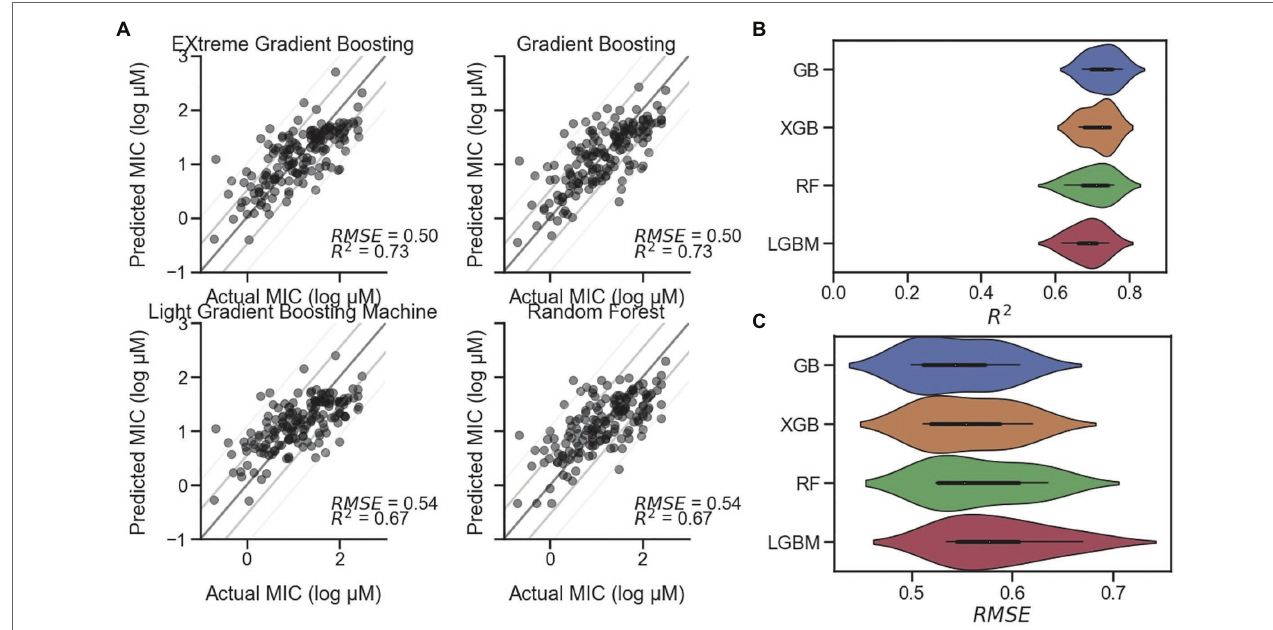
FIGURE 4 | Comparison of MIC prediction models. Four regression models for predicting AMP MIC values against E. coli . (A) Representative scatterplots of Predicted vs. Actual MIC (log μ M) of EXtreme Gradient Boosting (XGB), Gradient Boosting (GB), Light Gradient Boosting Machine (LGBM), and Random Forest (RF) predictions on holdout test dataset with RMSE and R 2 values displayed. Lines represent standard diagonals, in addition to the diagonal +/ − 1 and 2 SDs of the points. (B) Results of cross validation using shuffled split ( n = 25) shown as a violin plot for each model, sorted from highest to lowest mean R 2 value, with GB at the top with a median of 0.73. (C) Cross validation results for RMSE sorted from lowest to highest mean RMSE value, with GB at the top with a median of